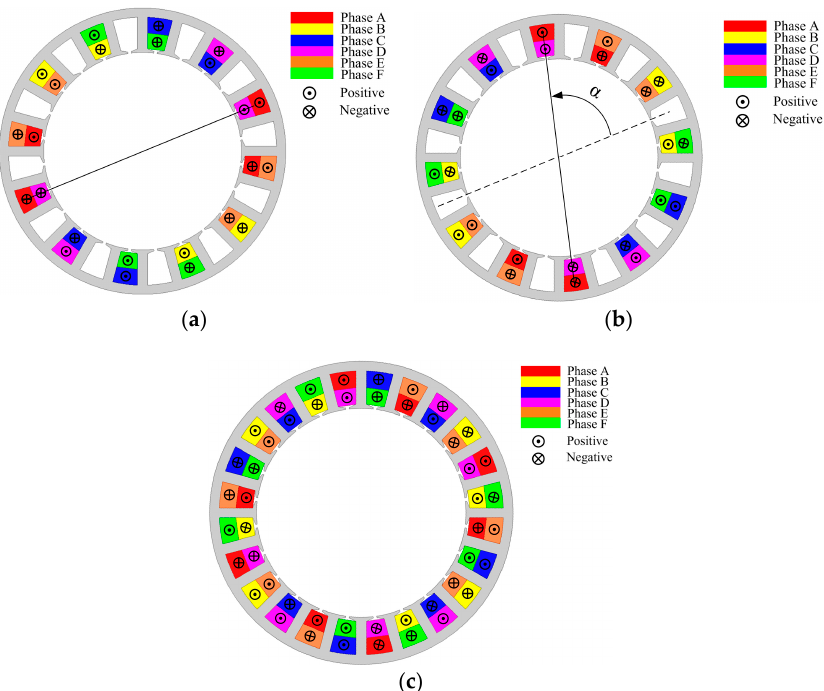
Figure 3. The six-phase 24-slot/10-pole winding layout and the stator shifting of two sets of six-phase 12-slot/10-pole winding layouts: ( a ) The first set of the 12-slot/10-pole winding layout; ( b ) The second set of the 12-slot/10-pole winding layout; ( c ) The 24-slot/10-pole winding layout. Here, to avoid an uneven teeth stator, the angle α between the two stators is limited to (2 k − 1)360°/ Q , where k is a positive integer. Assuming that the magnitude of the 7th harmonic of one Winding V is F 7 , the sum of the 7th harmonic of the two sets of Winding V can be obtained as follows: